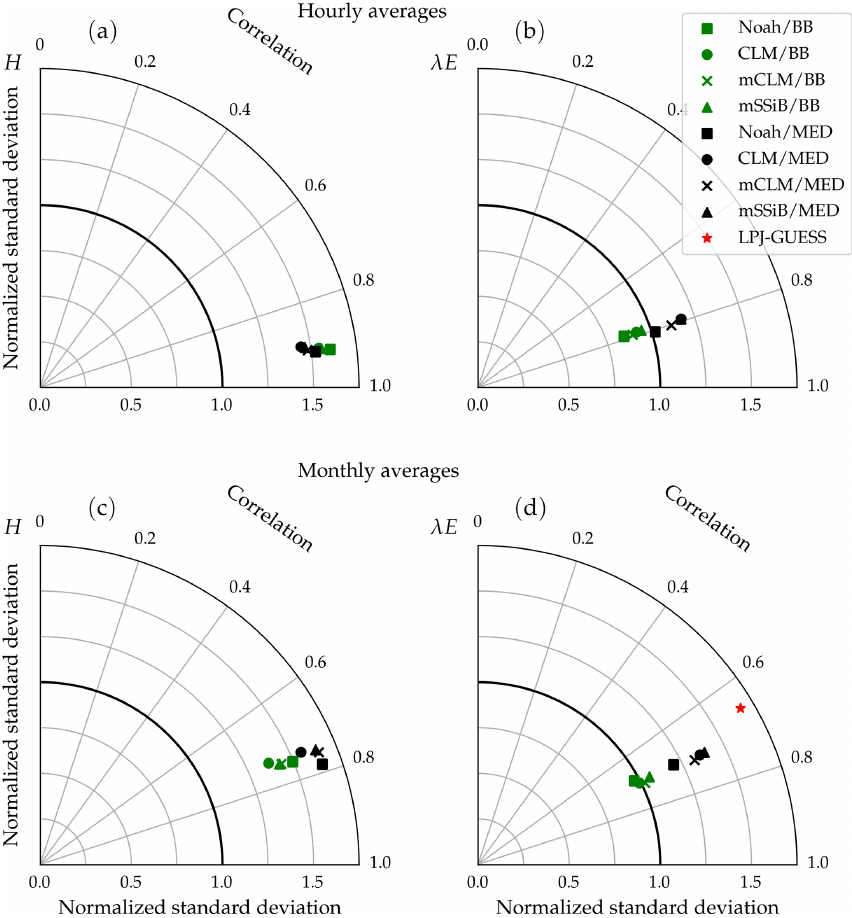
Figure 15. Average performance statistics for each model configuration, obtained from modelled and measured hourly (a, b) and monthly (c, d) fluxes of sensible and latent heat flux. The different symbol shapes represent different water uptake response functions (squares: NOAH type; circles: CLM type; crosses: modified CLM type; triangles: SSiB type), and the different colours represent different stomatal conductance schemes (green: Ball–Berry type; black: Medlyn). The red star represents average performance statistics for monthly latent heat fluxes derived from the standard LPJ-GUESS